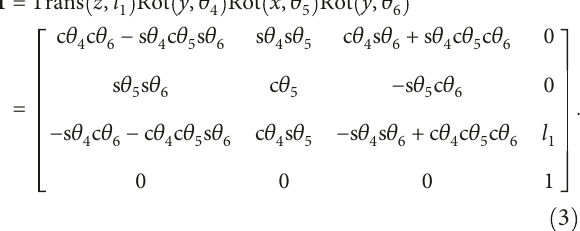
Figure 3: Points c and d located on the